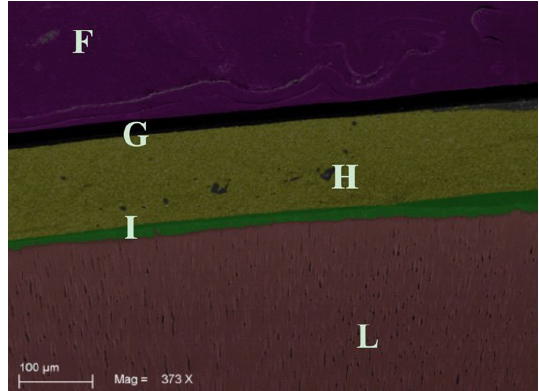
Figure 3. Image of Group 1. This image shows the interaction between the impression material and